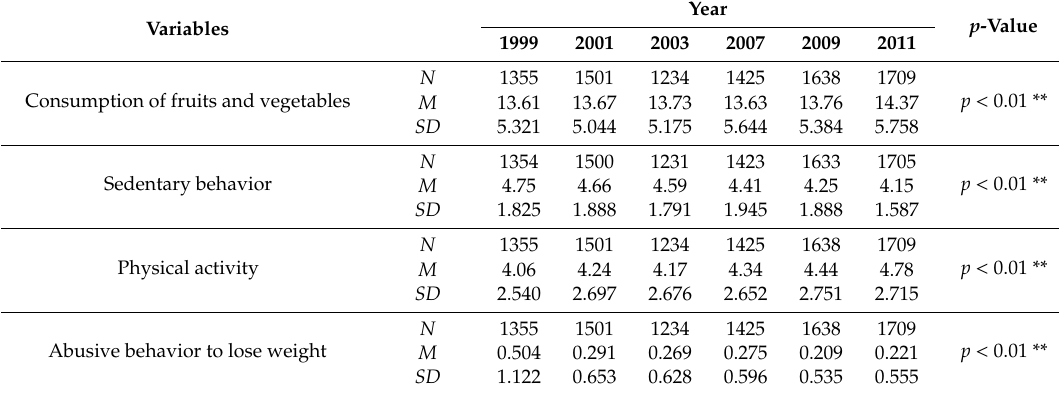
Table 2. Di ff erences in the variables of the years, from 1999 to 2011, from the Factorial ANOVA.